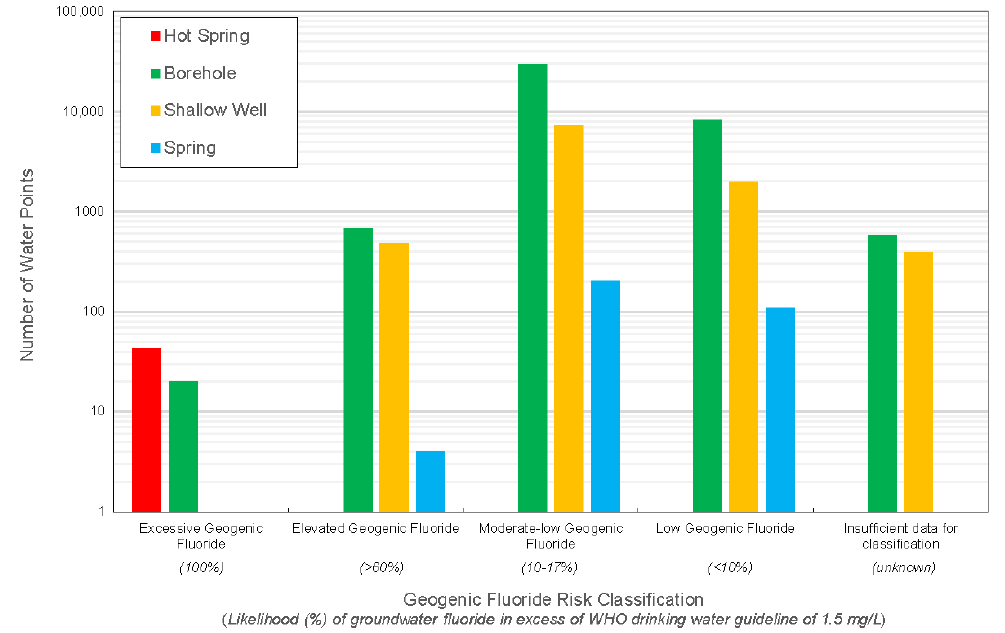
Figure 6. Breakdownsummaryofallwaterpointdata(functionalandpartlyfunctional, directgroundwater Figure 6. Breakdown summary of all water point data (functional and partly functional, direct sources–extracted from mWater) used in this study, per geogenic fluoride groundwater sources–extracted from mWater) used in this study, per geogenic fluoride classification.